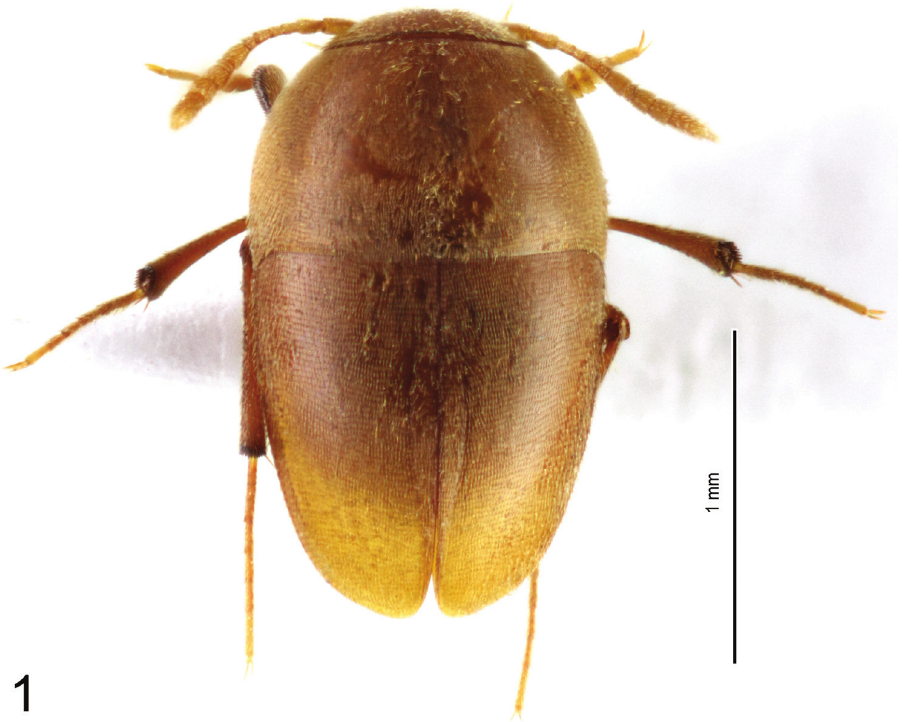
Figure 1. Ptomaphaginus troglodytes sp. n., male holotype from Shuiboshu Dong cave, habitus in dorsal view. Pronotum transverse, 1.6 times wider than long, the largest width just before the base. Lateral sides arcuate, the posterior angles clearly protruding behind the posterior margin. Pronotal surface with transverse